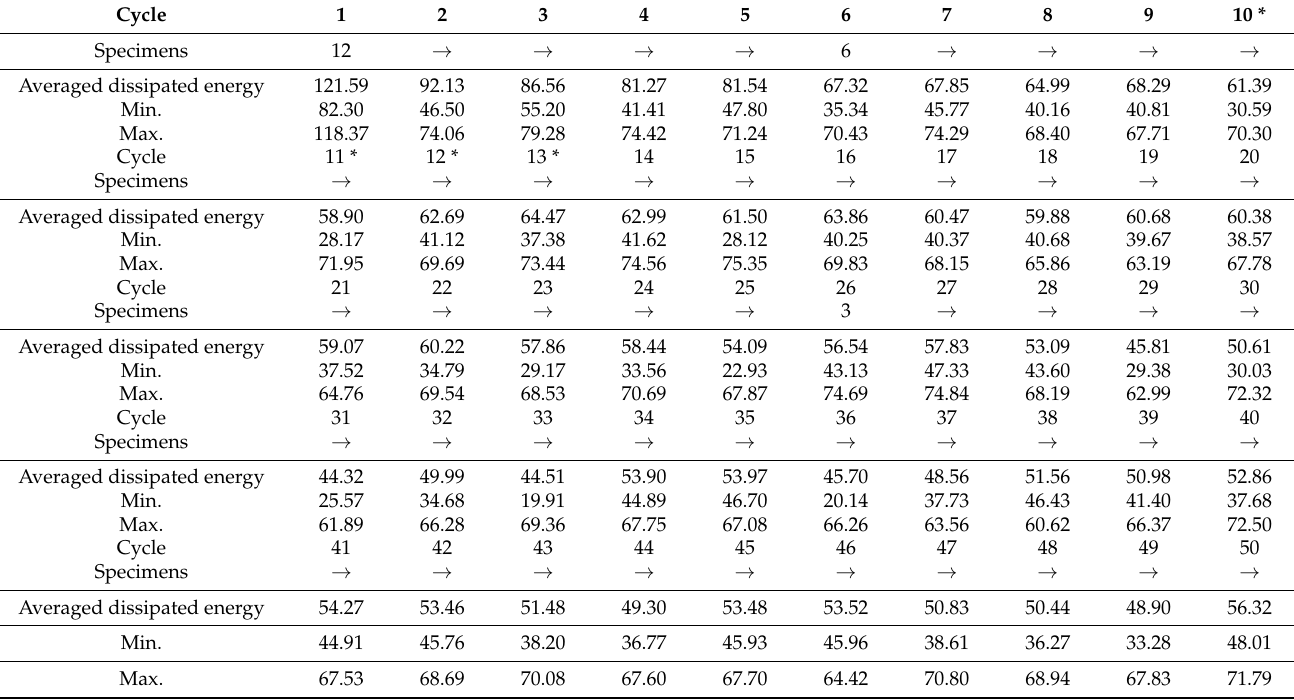
Table A3. Average energy dissipation per cycle (five cycles of 1235 kN after 5-785 kN and 5-1010 kN cycles) (unit = kN · mm). Cycle 1